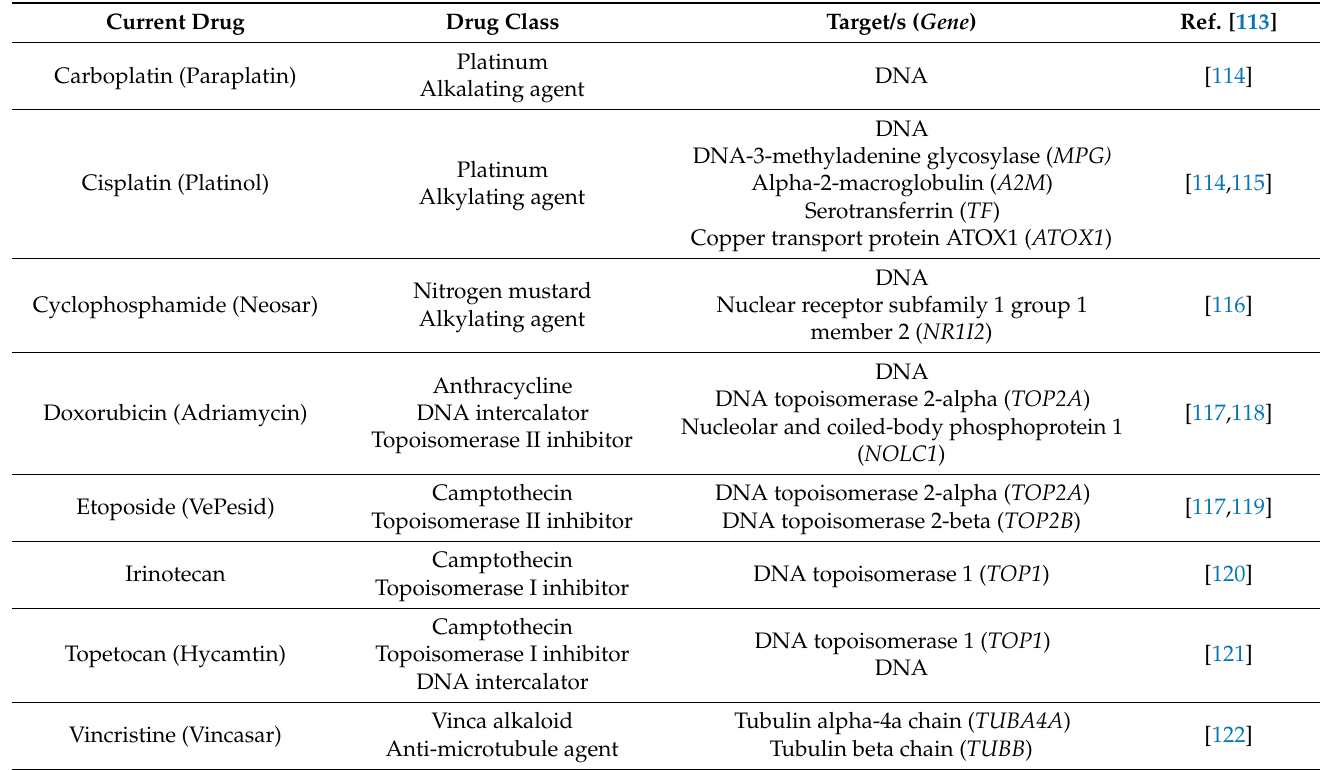
Table 3. Current standard-of-care drugs and prospective drugs evaluated for the treatment of neuroblastoma and their respective targets and mechanism of